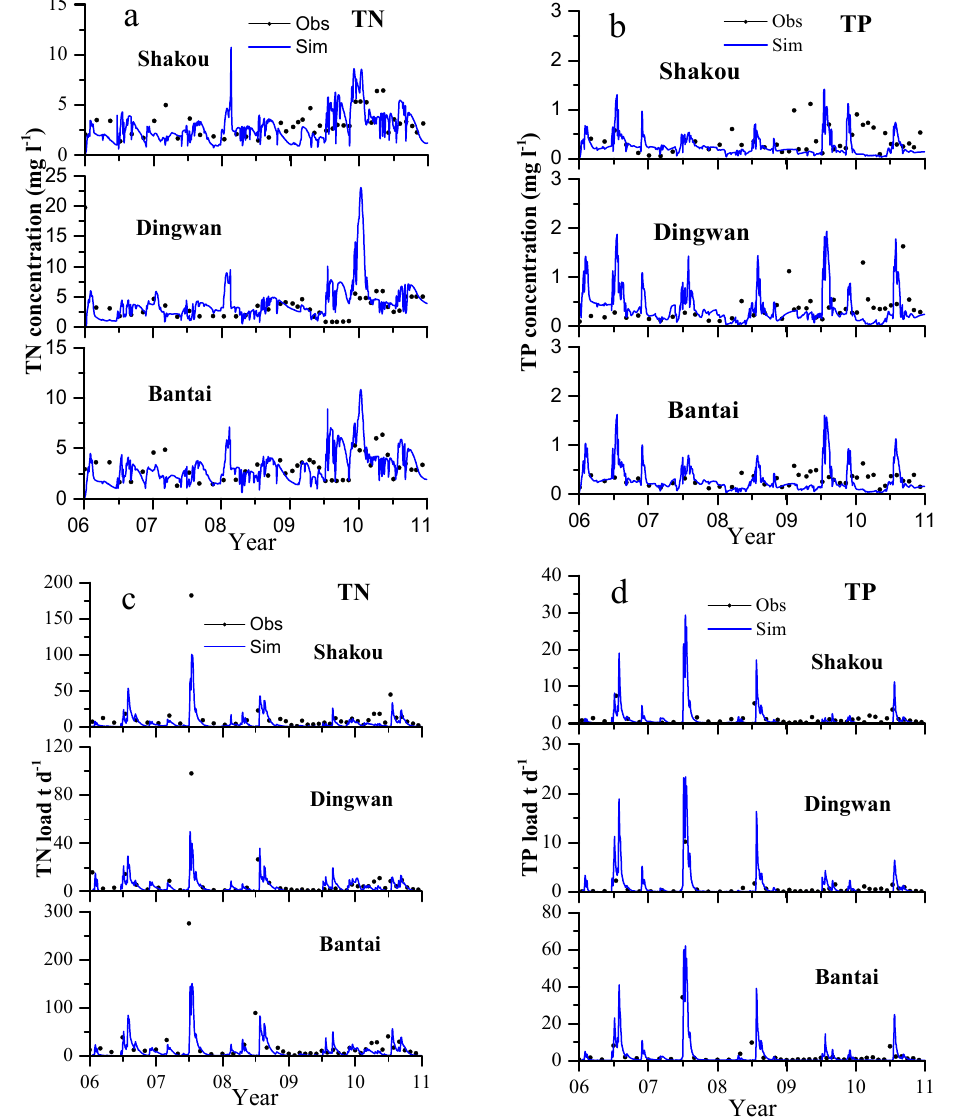
Figure 4. Observed and simulated daily TN and TP concentrations ( a , b ) together with the corresponding daily loads ( c , d ) during the calibration (2006–2008) and validation (2009–2010) periods.